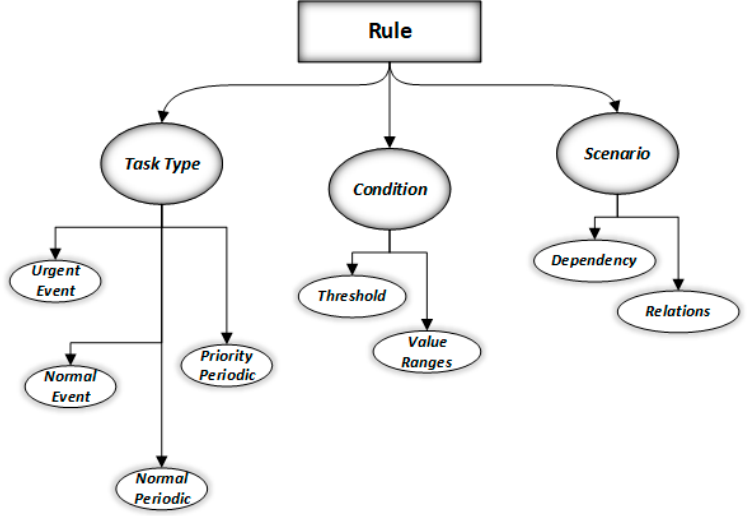
Figure 4. Defining of a rule in Inference Engine.